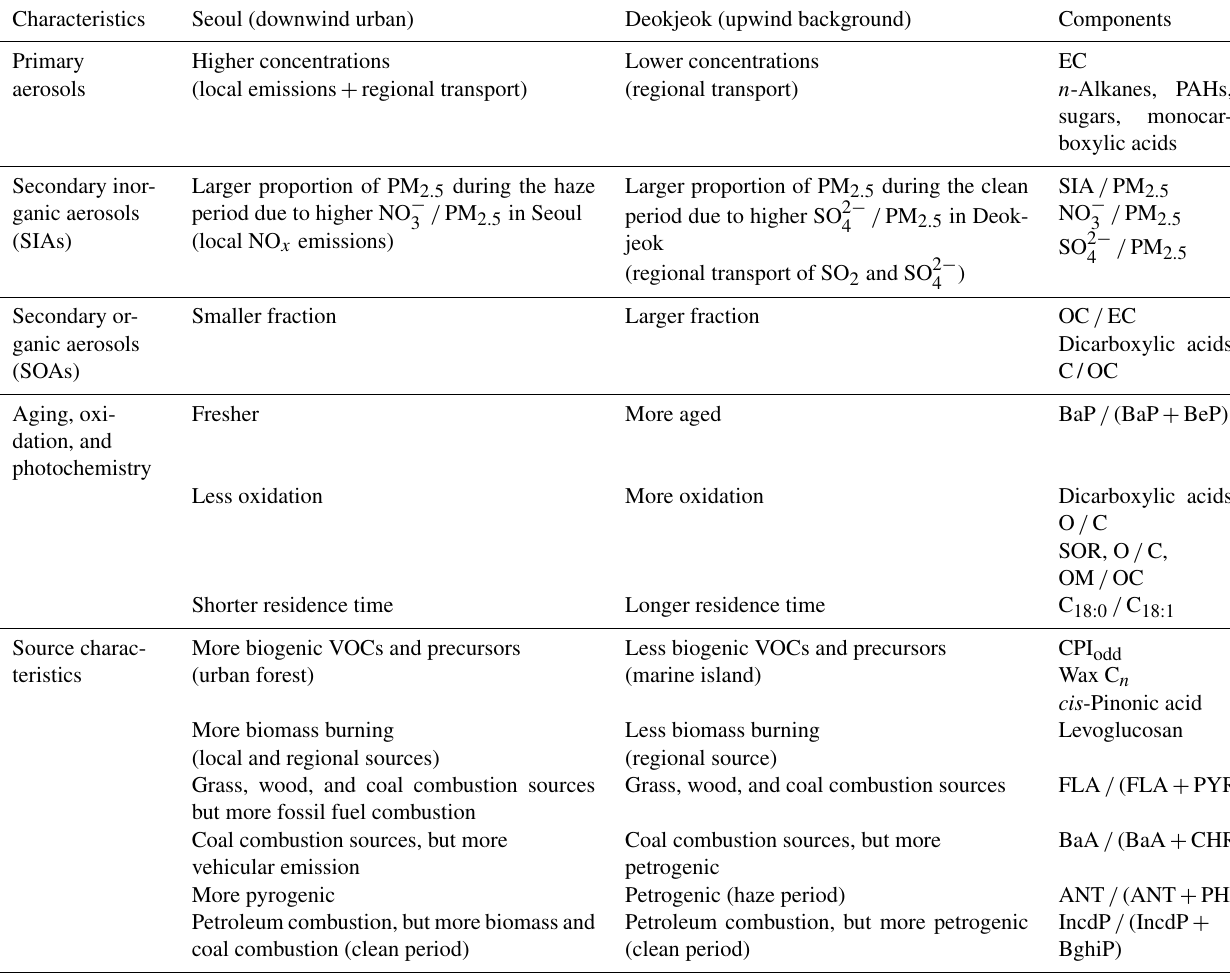
Table 3. Comparisons of chemical and source characteristics of PM 2 . 5 between Seoul and Deokjeok.